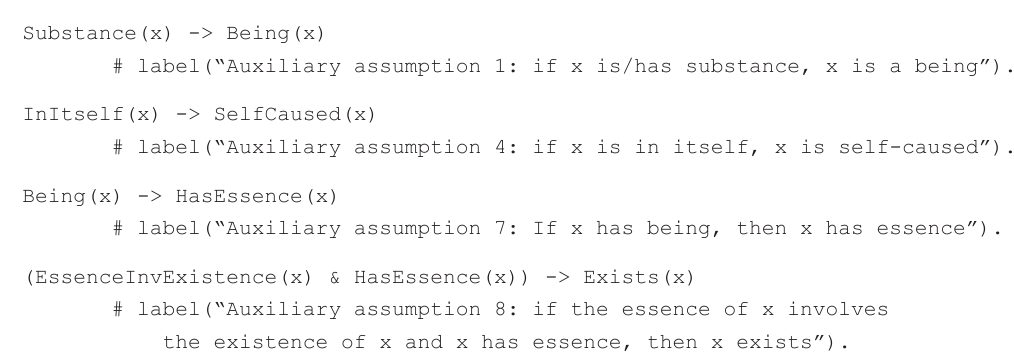
Figure 6: A set of Auxiliary Assumptions that are candidates for overcoming some of the deficiencies of